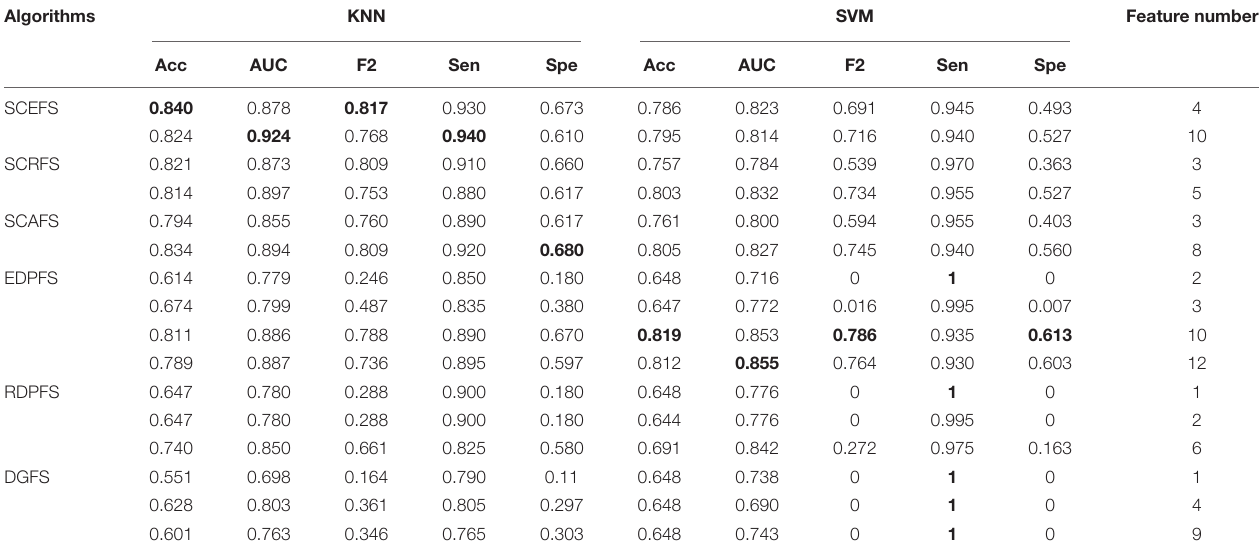
FIGURE 3 | Features displaying in the 2-dimensional space of each algorithm on Colon dataset, (A) and (G) SCEFS, (B) and (H) SCRFS, (C) and (I) SCAFS, (D) and (J) EDPFS, (E) and (K) RDPFS, (F) and (L) DGFS. TABLE 2 | Performance comparison of KNN and SVM classifiers on Colon dataset by our algorithms and unsupervised feature selection algorithms based on density peaks. Algorithms KNN SVM Feature